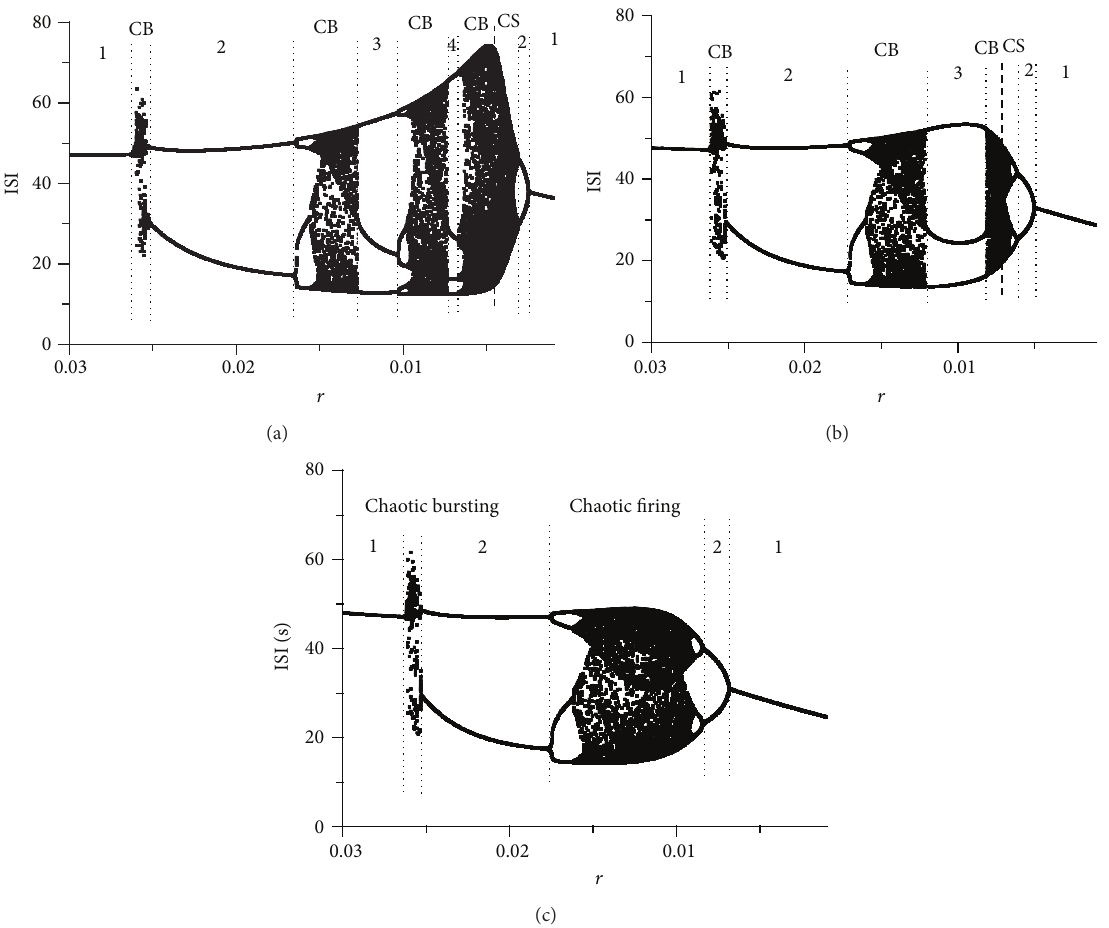
Figure 2: Bifurcation processes of the ISI series of firing patterns simulated using the HR model along lines shown in Figure 1 ( 0.001 < 𝑟 < 0.03 ). (a) Line L3: 𝐼 = −36 × (𝑟 − 0.0265) + 2.53 . (b) Line L2: 𝐼 = −44 × (𝑟 − 0.0265) + 2.53 . (c) Line L1: 𝐼 = −50 × (𝑟 − 0.0265) + 2.53